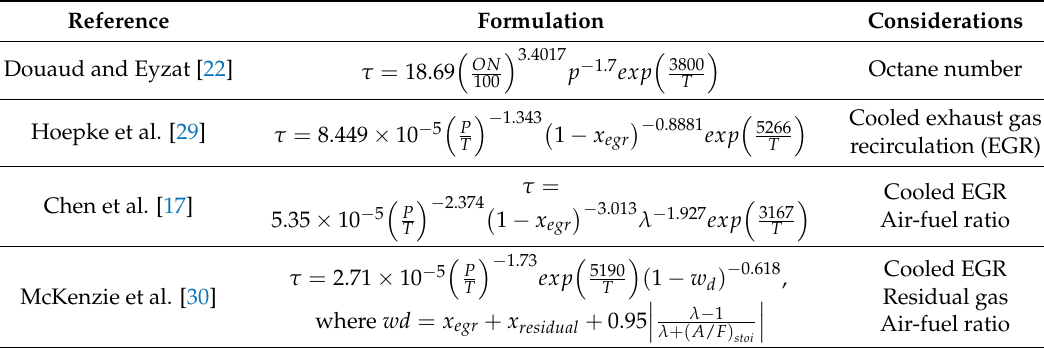
Table 1. Zero-dimensional ignition delay